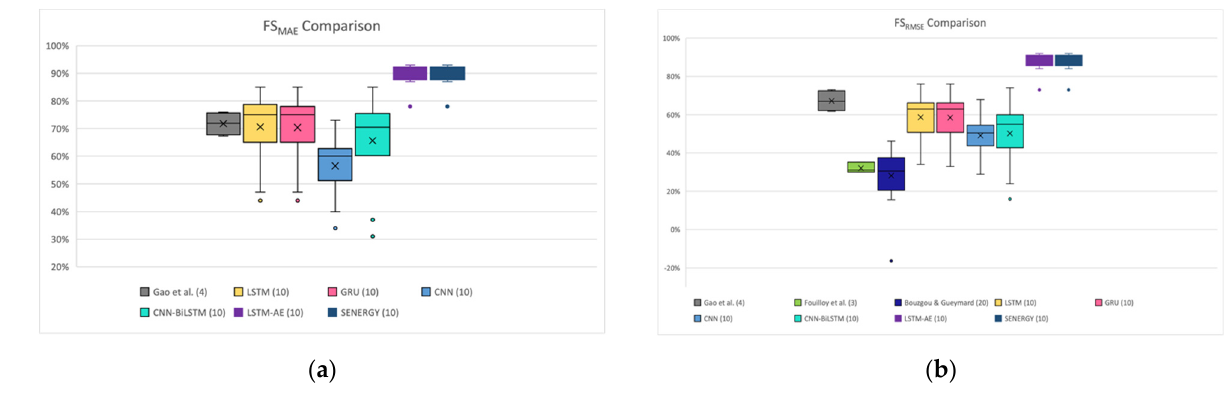
Figure 47. Comparison of multiple works based on: ( a ) FS MAE ; ( b ) FS RMSE .